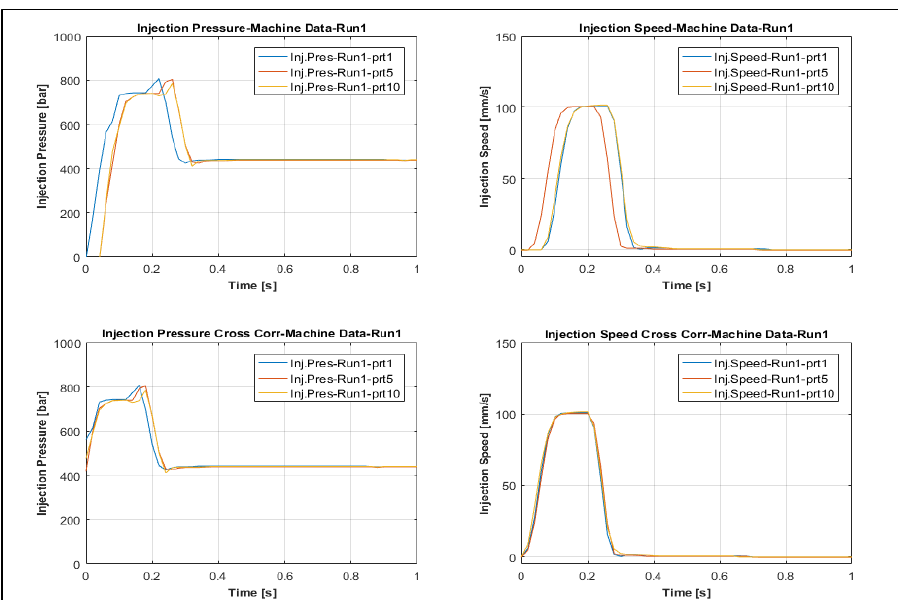
Figure 9. Signals of injection speed and pressure from part cycles 1, 5, and 10 of Run-1 before ( top ) and after cross correlation alignment ( bottom ).